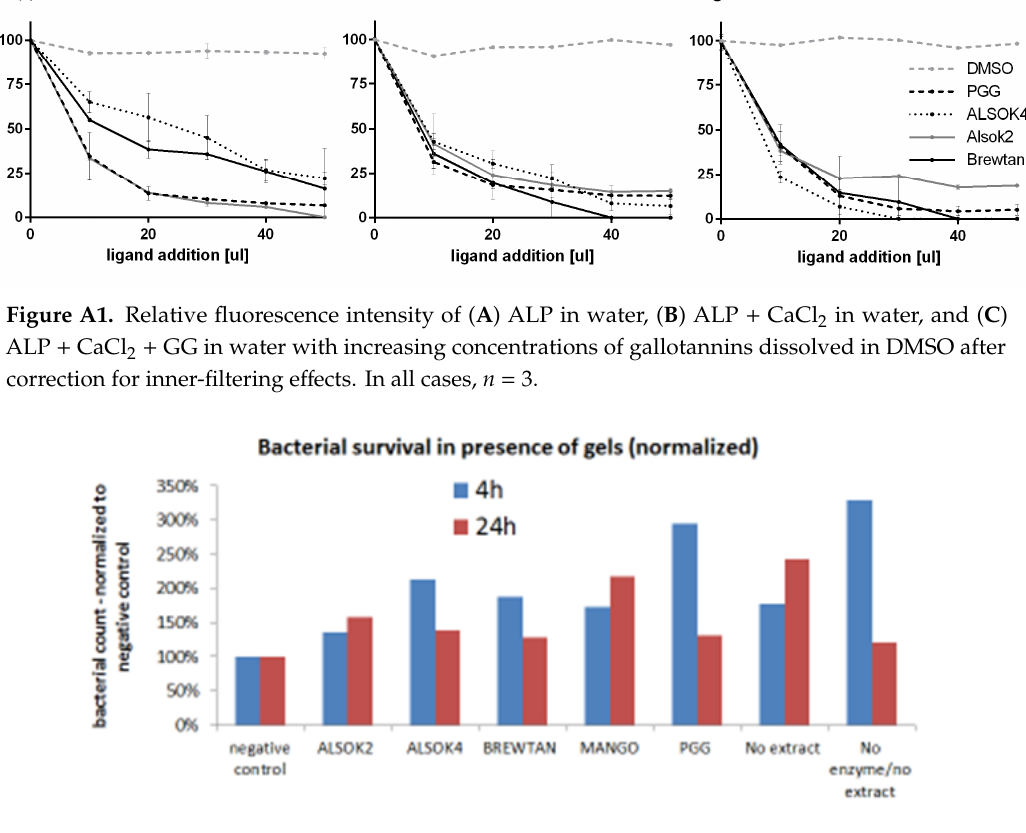
Figure A2. Survival of E. coli in the presence of growth of mineralized hydrogels containing di ff erent gallotannin preparations after 4 (blue) and 24 h (red). In all cases, n = 1.